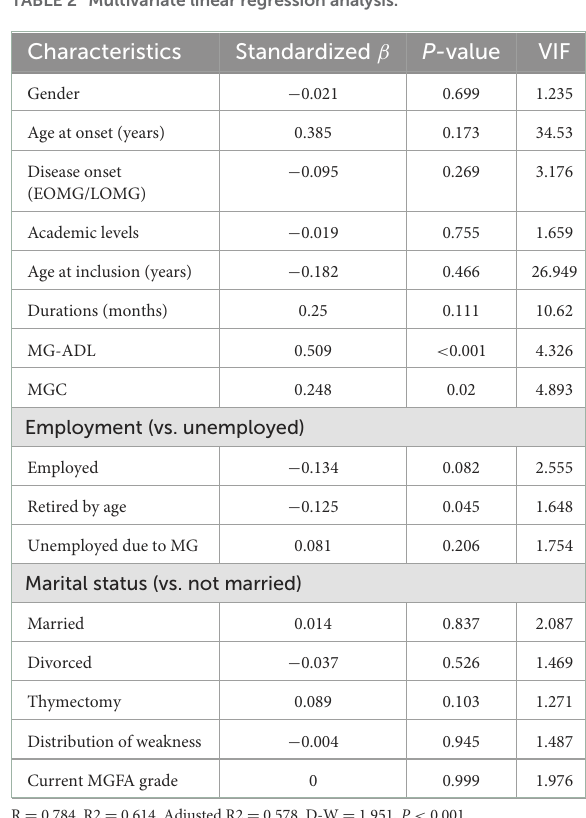
TABLE 2 Multivariate linear regression